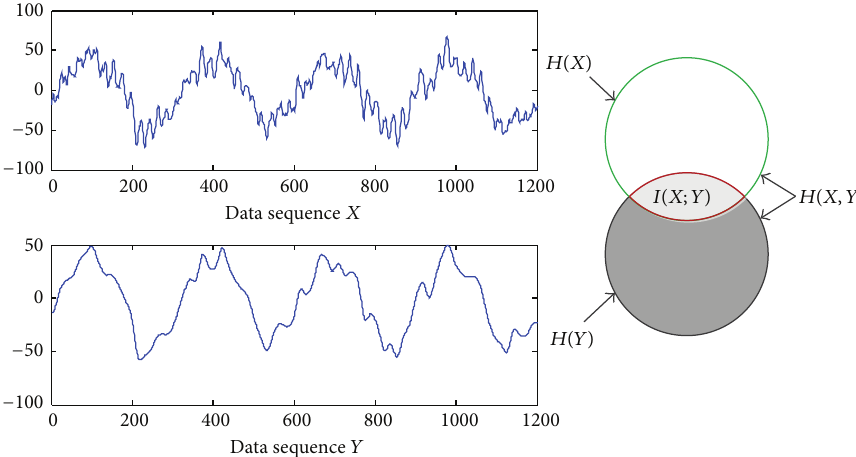
Figure 2: Relationships among entropies and mutual information.